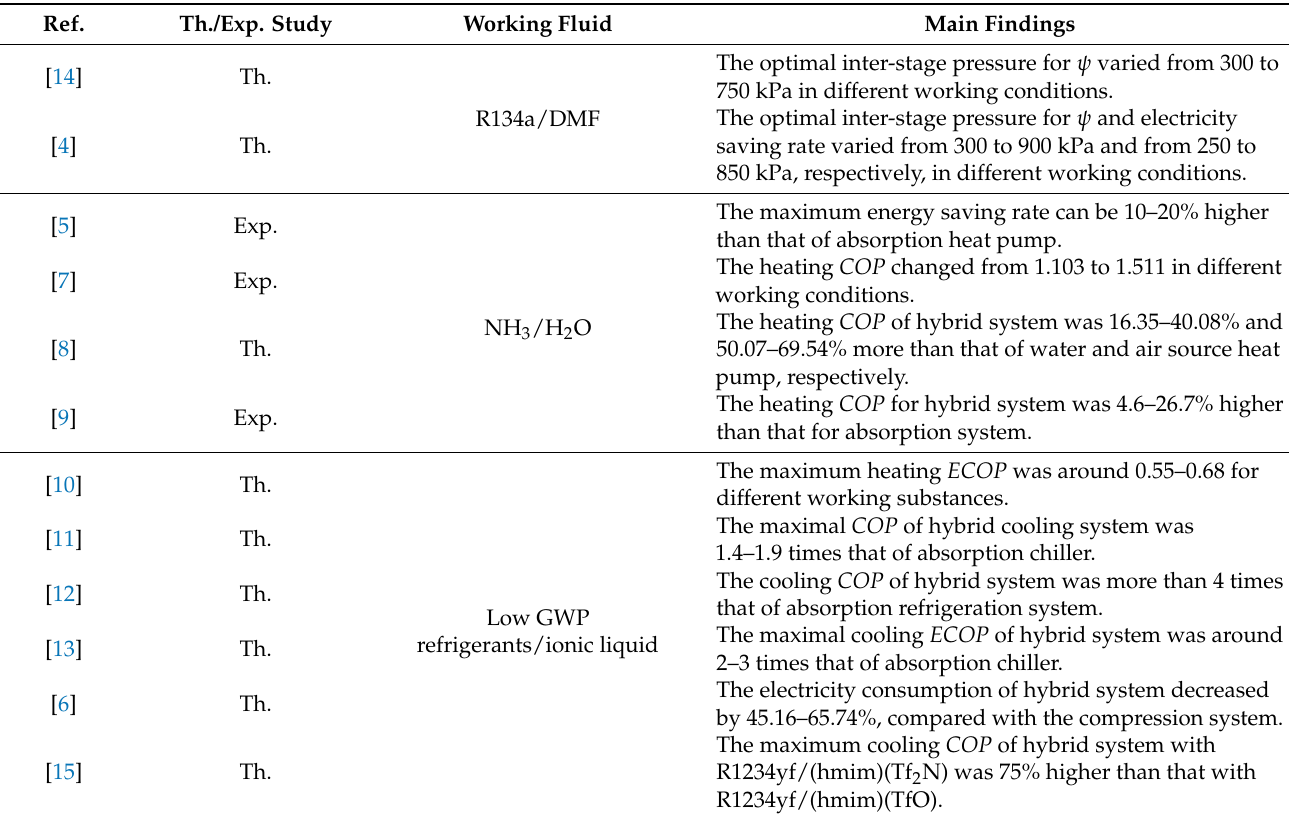
Table 1. Summaryofliteraturesurveyontwo-stagecyclewiththermalandmechanicalcompression processes.